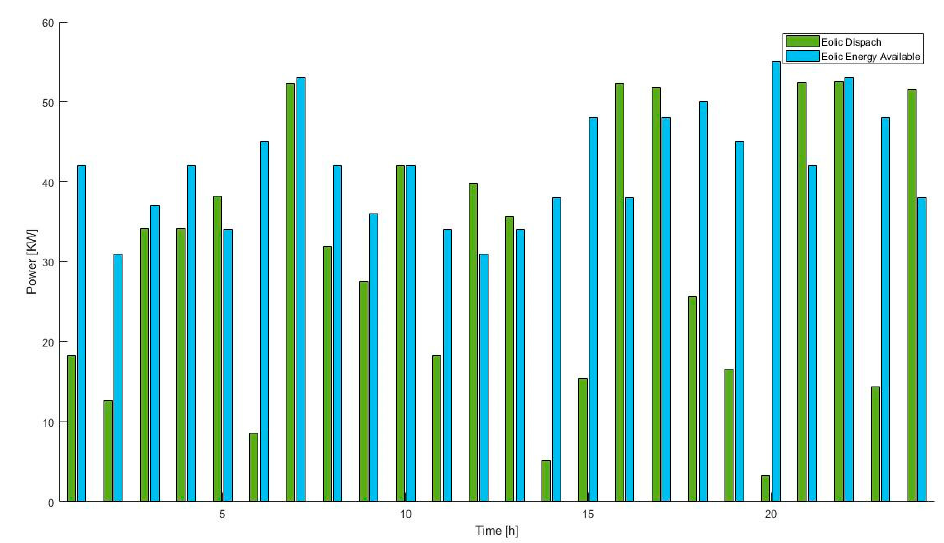
Figure 3. Wind power dispatched (green) vs. most probable power (blue) during the 24 h of the day.